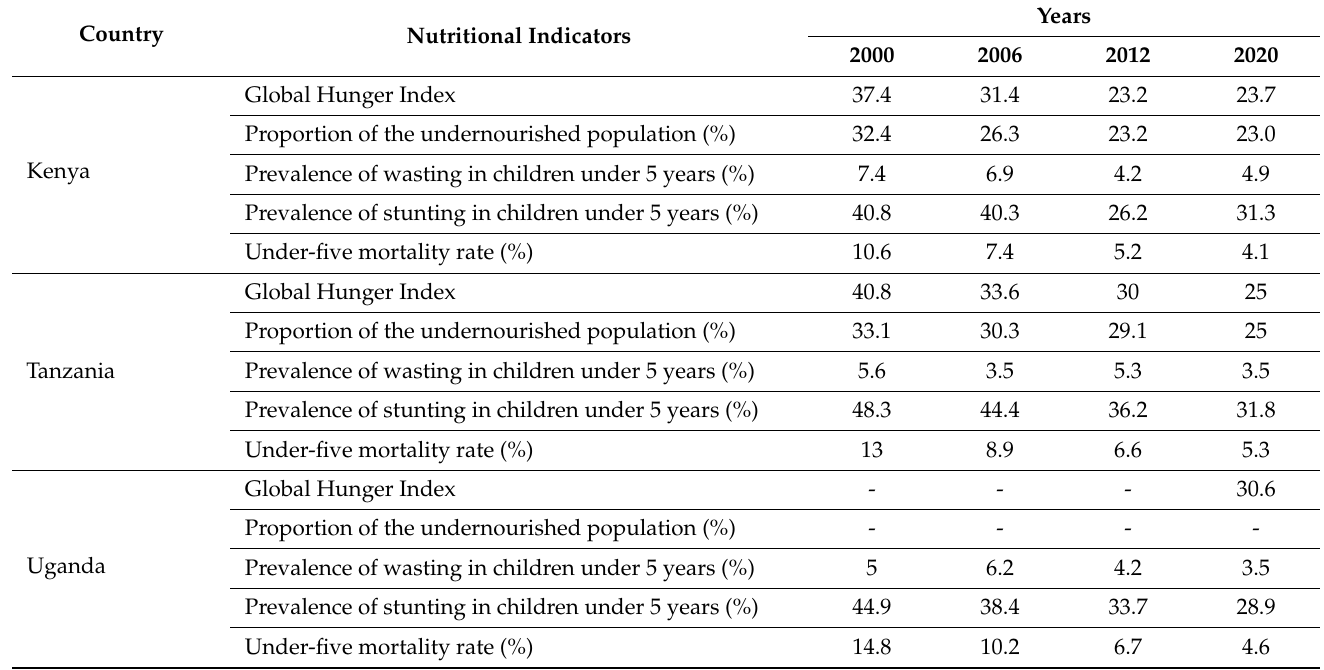
Table 1. Global Hunger Index and nutritional indicators for Kenya, Uganda, and Tanzania in 2020. Country Nutritional